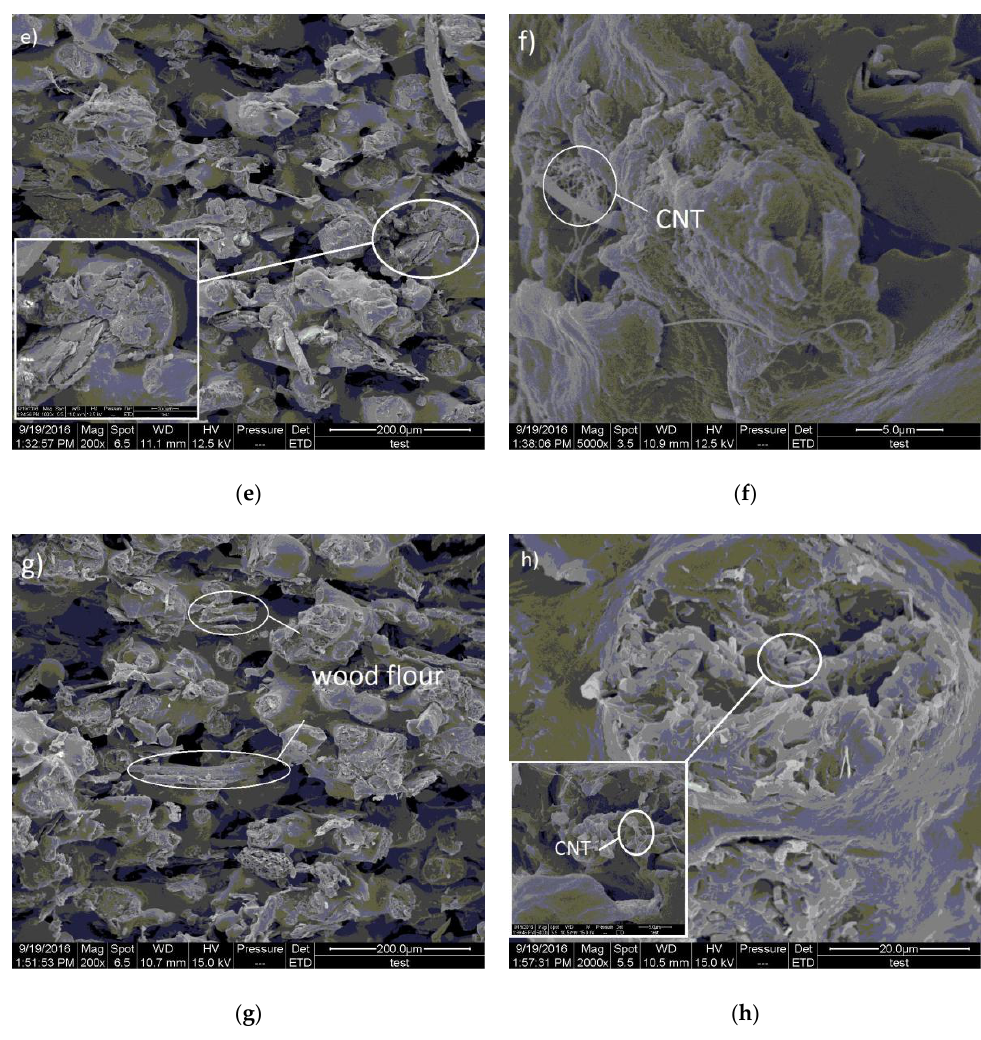
Figure 7. Higher magnification SEM images of fracture surfaces of specimens via SLS with CNT concentrations of ( a , b ) 0%, ( c , d ) 0.05%, ( e , f ) 0.1%, and ( g , h ) 0.15%.